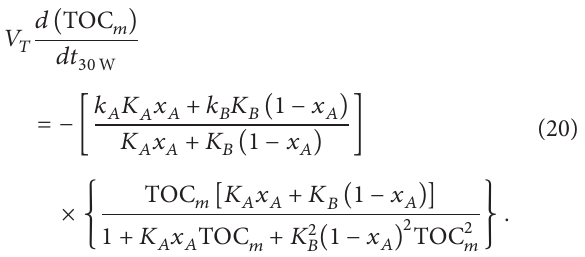
Table 3: Fitting statistical parameters for binary